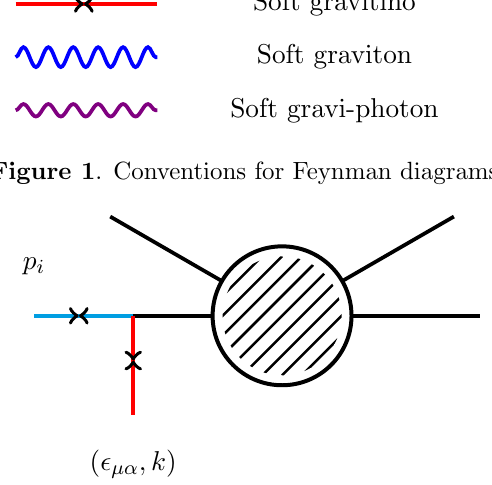
Figure 2 . Feynman diagram for single soft